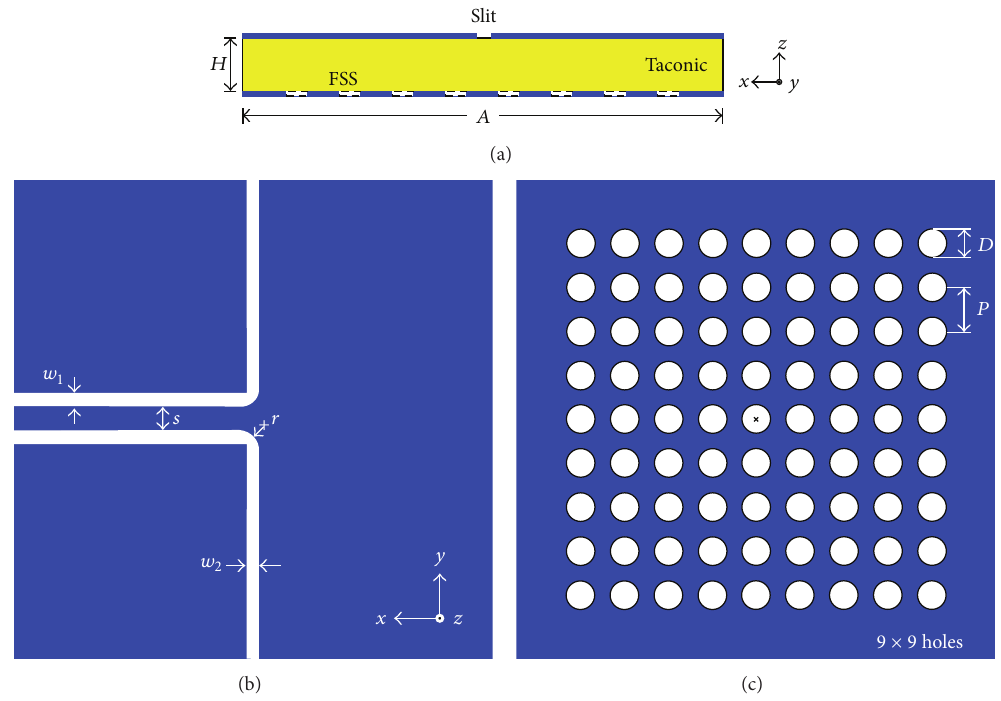
Figure 1: Antenna geometry: (a) side view, (b) top view for the feeding structure, and (c) bottom view for the FSS.